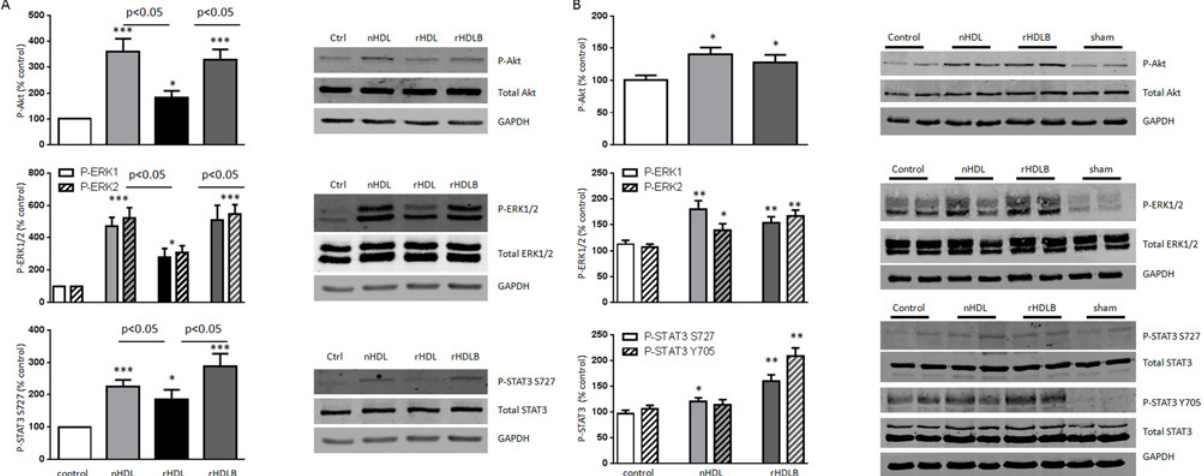
Fig 7. Activation of intracellular signaling pathways in vitro and in vivo . A. Western blot analysis was performed with proteins extracted from neonatal cardiomyocytes treated with nHDL, rHDL (apoAI + POPC) or rHDLB (apoAI + POPC+ S1P) for 5min (n = 7 – 11). Specific bands corresponding to phosphorylated Akt, ERK1/2 and STAT3 were quantified by densitometry, normalized using GAPDH expression and given as a percentage of the control. B. Western blot analysis of proteins extracted from hearts submitted to 45min of LAD occlusion followed by 5min of reperfusion. Native HDL (nHDL) or rHDLB were injected one minute before the reperfusion (n = 9). Data are mean ± SEM. * p < 0.05, ** p < 0.01, *** p < 0.001 vs control, using unpaired-student